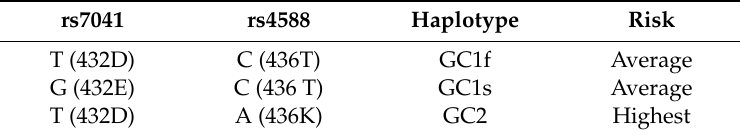
Table 4. GC Haplotypes and Vitamin D Deficiency